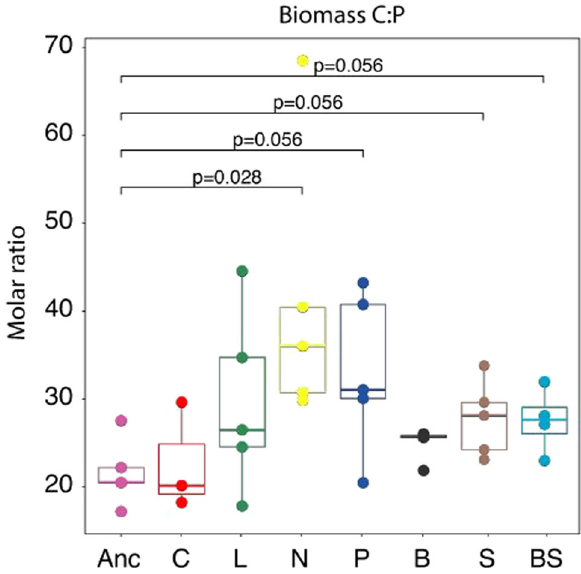
Units were missing on the y-axes labels of Supplementary Figure 7 (middle (mg.mg − 1 ) and right panels ( μ g.mg − 1 )). The HTML has been updated to include a corrected version of the Supplementary